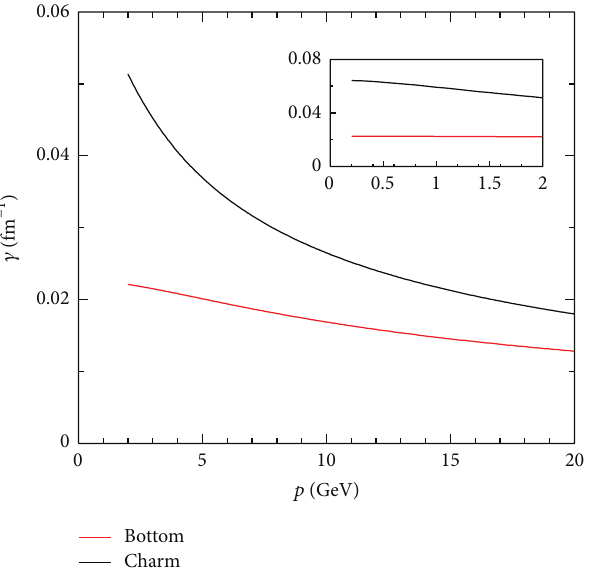
Figure 2: Suppression of transverse momentum of charm quarks in QGP as a function 𝑝 𝑇